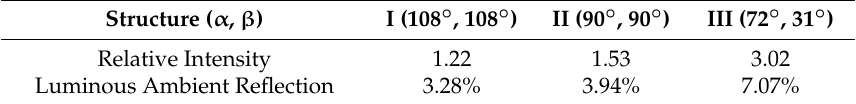
Table 2. Relative light intensity and luminous ambient reflection of structure I, II, and